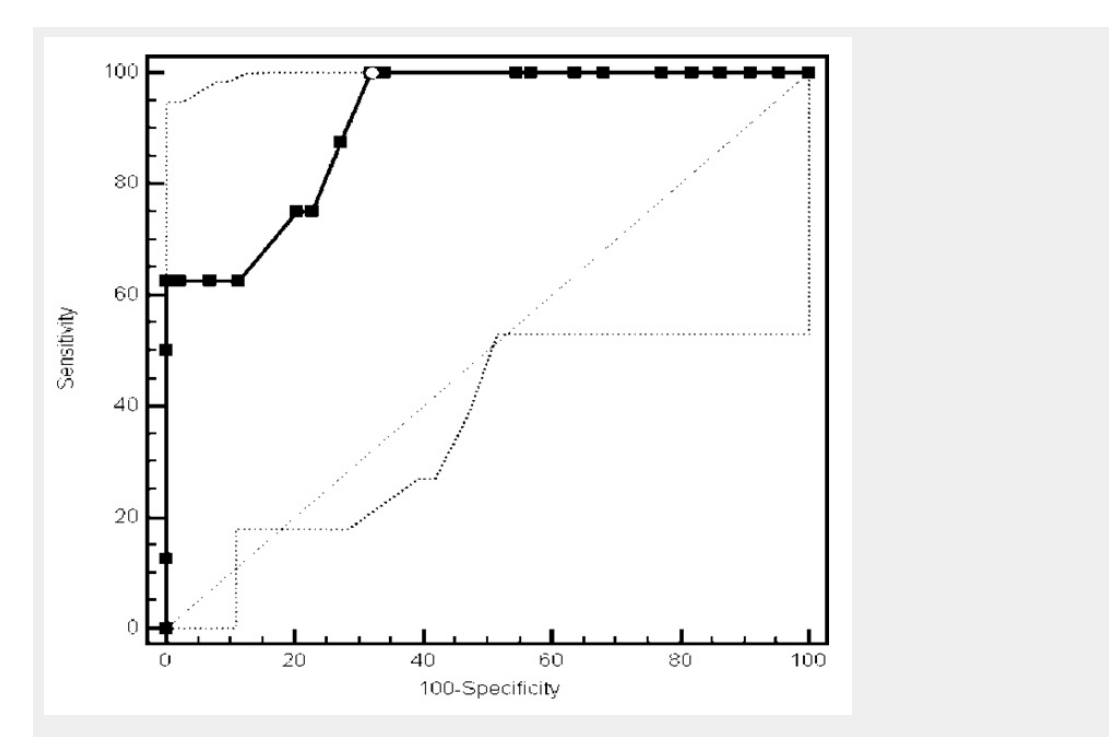
Figure 2 Receiver operating characteristic (ROC) curve for prediction of early hypoparathyroidism using intraoperative rapid PTH assay. Area under the curve (AUC) = 0.912 (SE = 0.05, 95% CI = 0.8 – 0.973, P < 0.0001). White dot along the curve represents optimal cutoff value (PTH < 27 pg/ ml). This had sensitivity of 100% (95% CI = 63.1% – 100%), specificity of 68.2% (95% CI = 52.4% – 81.4%, LR+ of 3.1 (95% CI = 2.6 – 3.8), LR– of 0, PPV of 36.4% (95% CI = 17.2% – 59.3%), and NPV of 100.0% (95% CI = 88.1% –